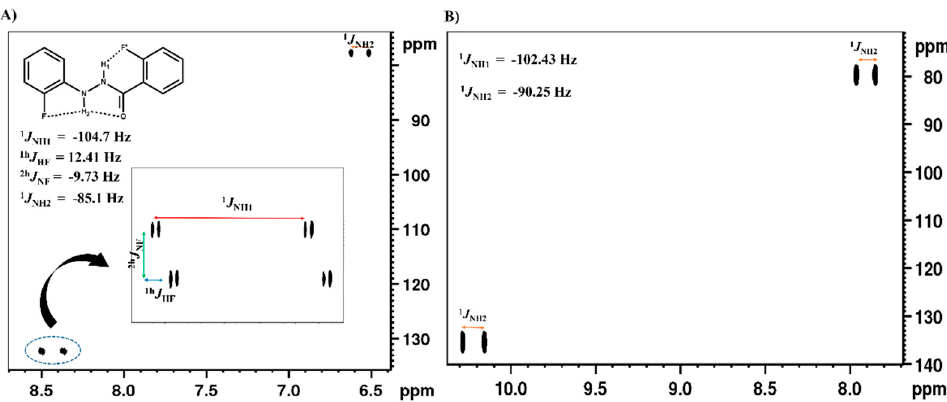
Figure 22. 400 MHz coupled 15 N- 1 H-HSQC spectra of molecule 20 in the solvents ( A ) CDCl 3 and ( B ) DMSO- d 6 . The measured couplings and their signs are reported in the Figure 22A.